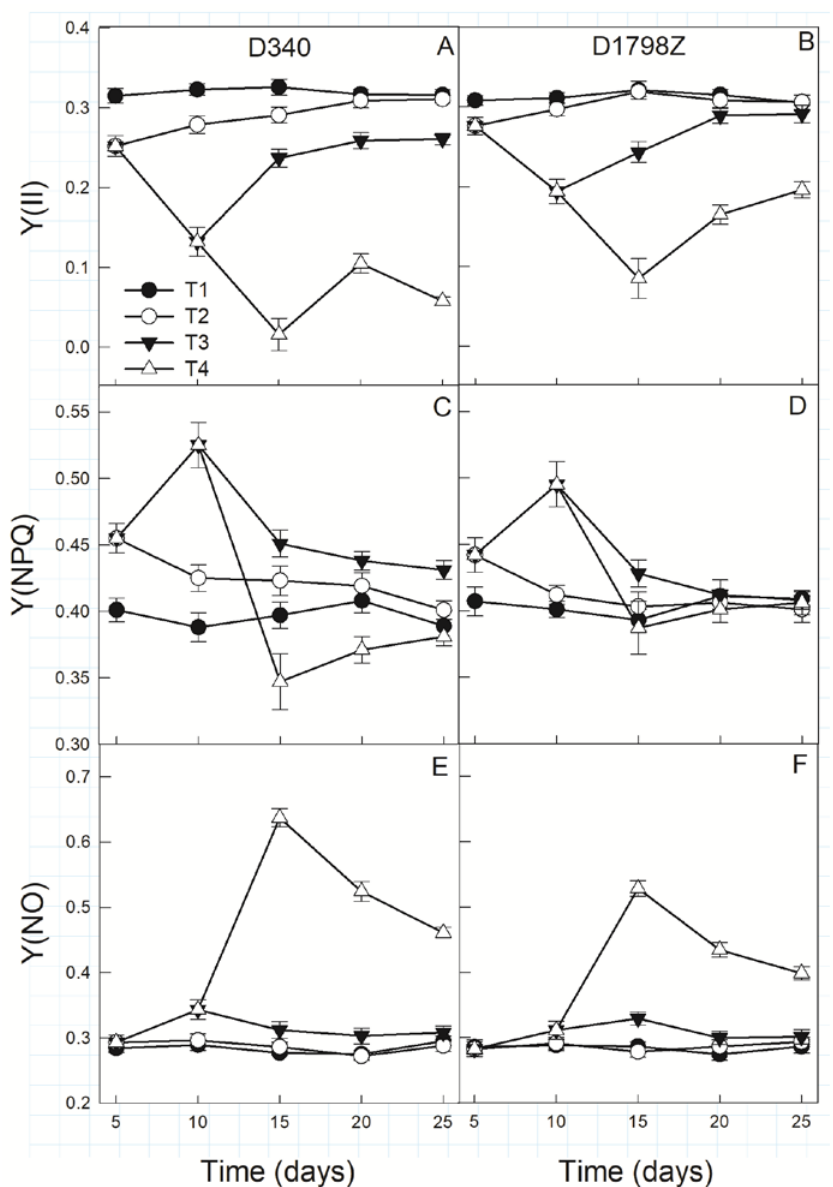
Figure 5. Effect of different drought durations and re-watering on Y(II), photochemical quantum Figure 5. E ff ect of di ff erent drought durations and re-watering on Y(II), photochemical quantum efficiency of PSII ( A – B ), Y(NPQ), quantum yield of regulated energy dissipation ( C – D ) and Y(NO), e ffi ciency of PSII ( A , B ), Y(NPQ), quantum yield of regulated energy dissipation ( C , D ) and Y(NO), quantum yield of non-regulated energy dissipation ( E – F ) of two maize lines. Each parameter is the quantum yield of non-regulated energy dissipation ( E , F ) of two maize lines. Each parameter is the average of three replicates. average of three